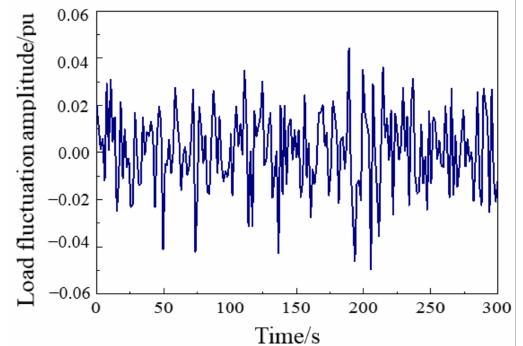
Figure 7. The 5 min load disturbance curve.